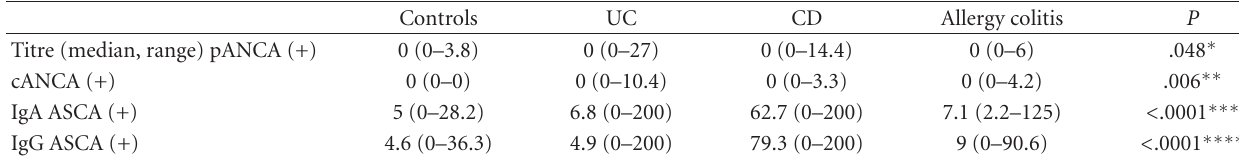
Table 3: Comparison between titres of ANCA and ASCA antibodies in groups. Controls UC